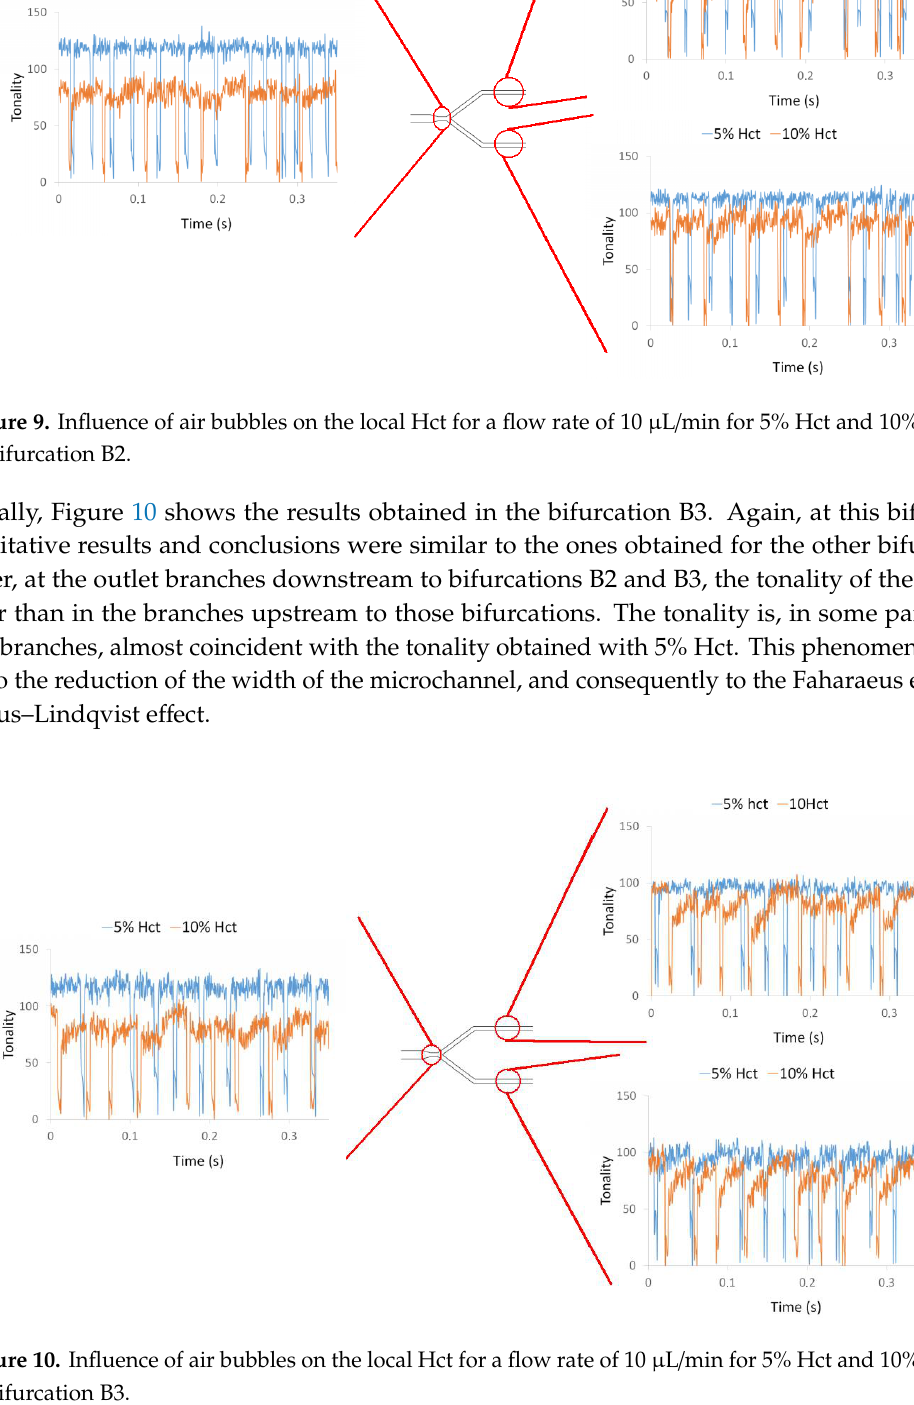
Figure 10. Influence of air bubbles on the local Hct for a flow rate of 10 µL/min for 5% Hct and 10% Hct at bifurcation B3.